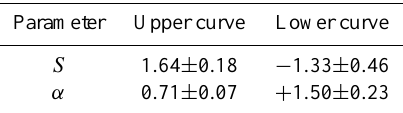
Table 1. Fit parameters of the limiting anisotropy for R ≤ 0 . 4AU. Table 2. Fit parameters of the limiting anisotropy for R > 0 .